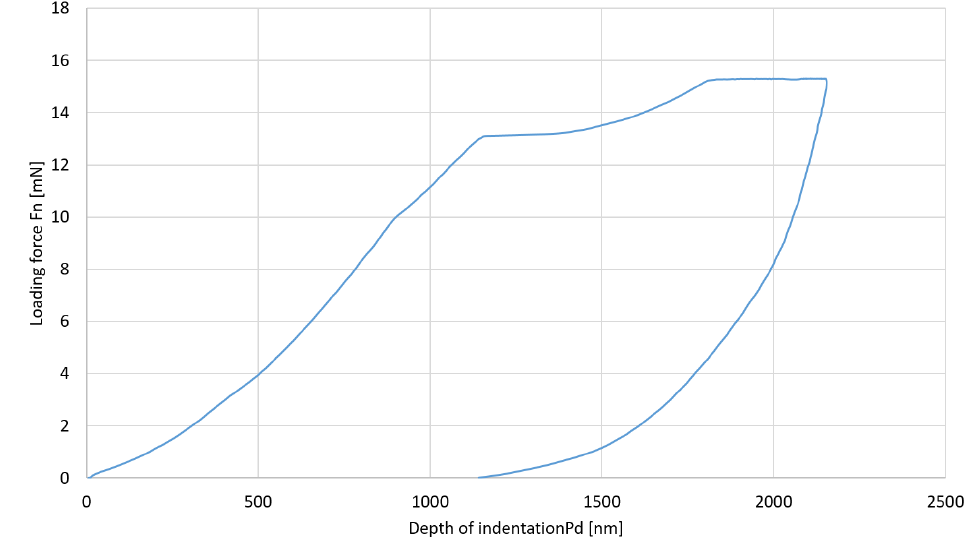
Figure 6. Typical indentation curves for forces greater than 12 mN causing fracture failure in the sample.